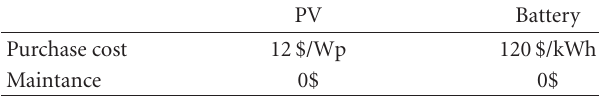
Table 3: Economical parameters